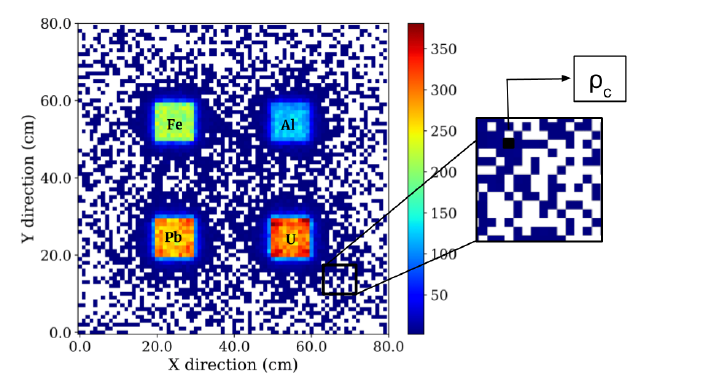
Figure 3. The figure showing the XY projection of scattering vertices (S-map) demonstrates the image analysis technique. Each pixel is attributed the analysis parameter: scattering vertex density ( ρ c ). The magnified section of the S-map displays the parameter ( ρ c ) of the highlighted pixel.